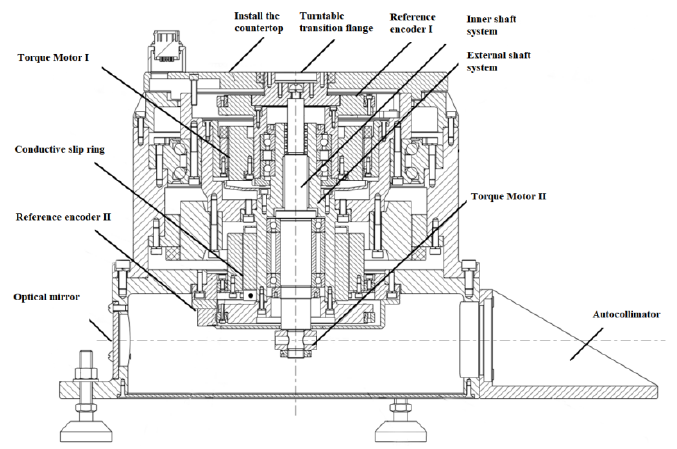
Figure 15. Moir é grating interpolation error precision detection platform. Figure 15. Moiré grating interpolation error precision detection platform. Figure 15. Moiré grating interpolation error precision detection platform.